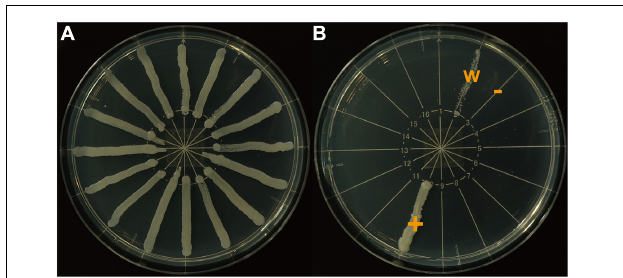
FIGURE 1 | Yeast nitrogen base plates used to determine threshold temperatures. (A) , all colonies growing well ( n = 16); (B) , colonies were divided into three growth categories: +, growing well; − , not growing; w, growing weakly.